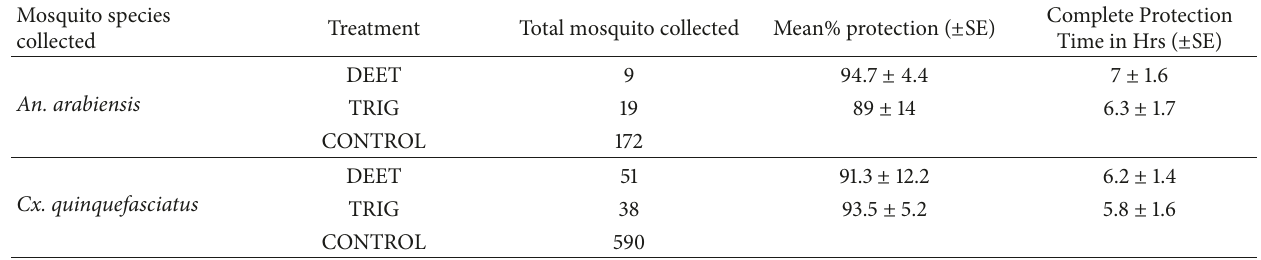
Table 3: Mean percentage (%) protection and Complete Protection Time of DEET and TRIG against mosquitoes in the field trials. Mosquito